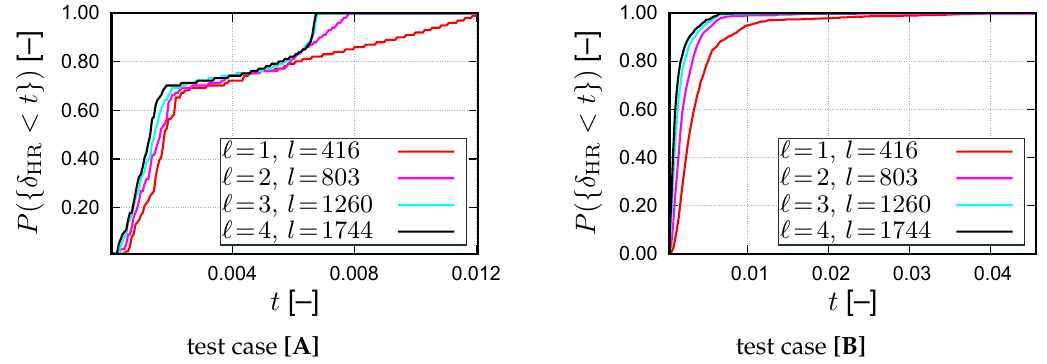
Figure 6. Statistical distribution function of the relative error of the hyper-reduction for different layers of elements added to the RID (cid:96)